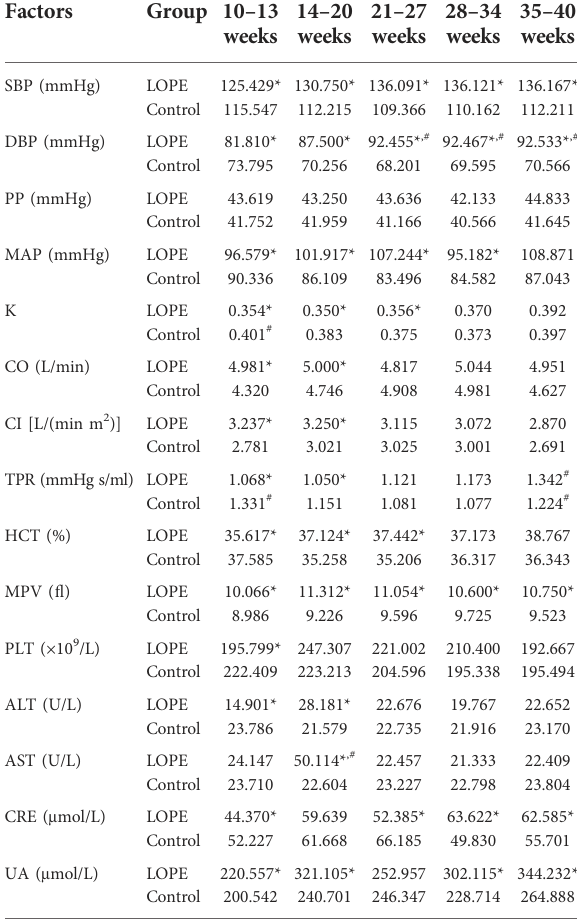
TABLE 11 Dynamic factors analysis of chronic hypertension complicated with